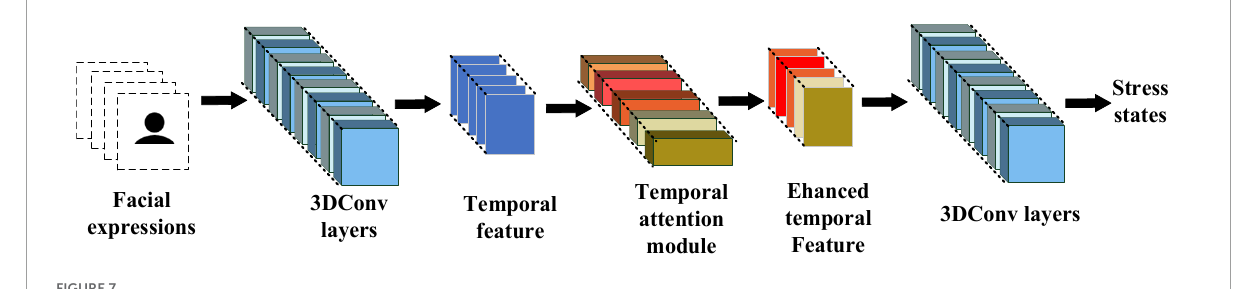
for distinguishing facial expressions. The identical scale is used to pool temporal information in traditional I3D, which makes important frames lost and trapped in local